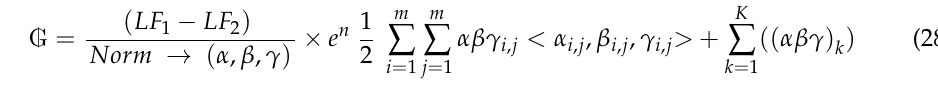
Figure 7. Blend minimization distance between two triangles using over-probability.